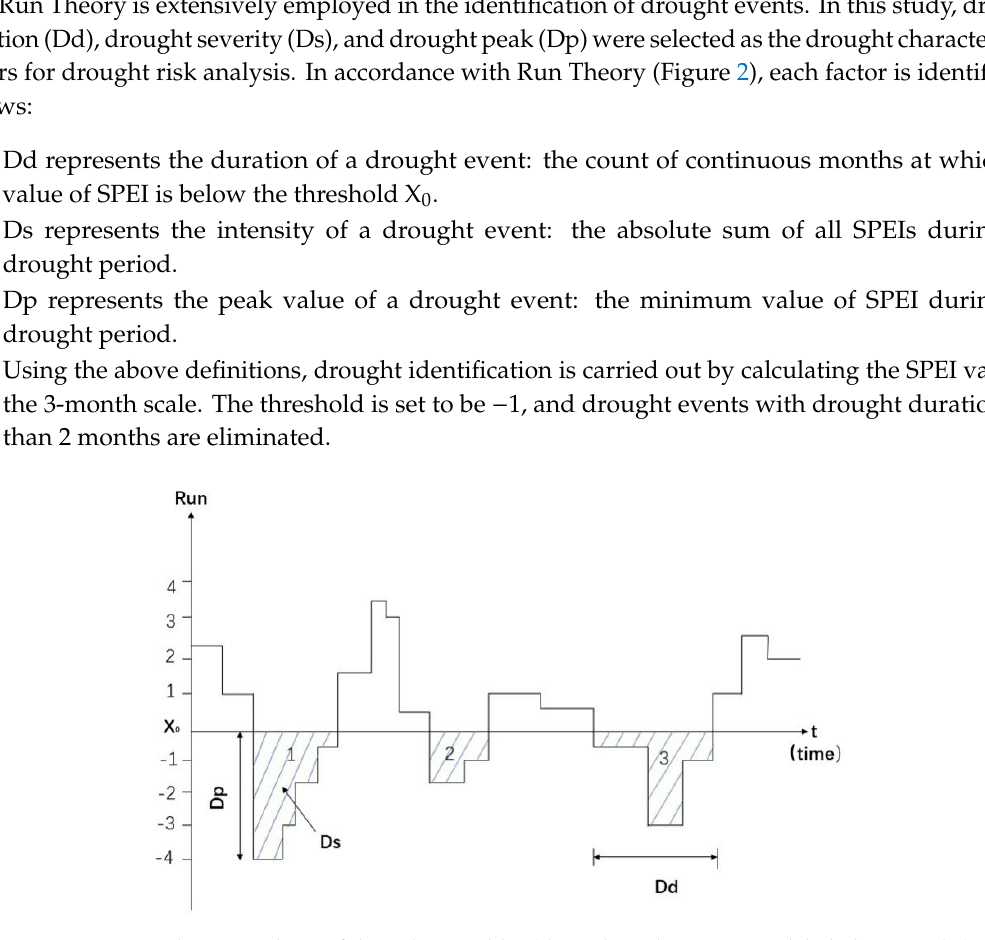
Figure 2. Run Theory analysis of drought variables (three drought events are labeled 1, 2, and 3).